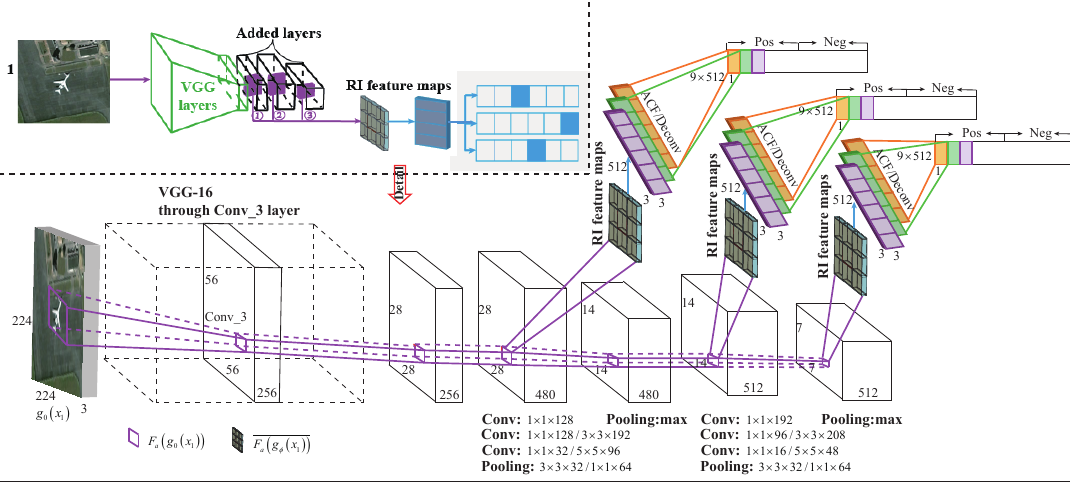
Figure 3. The illustration of multi-scale convolutional channel features. The features are learned by them passing through a VGG-16 network and an additional seven-layer network with an inception module. The specific implementation details are shown in the figure. To facilitate the effective detection of objects with different sizes, we generated the rotation-insensitive (RI) features at different scales. More specifically, the features in the shallow layer were applied to small-scale objects while deeper features were used for large-scale